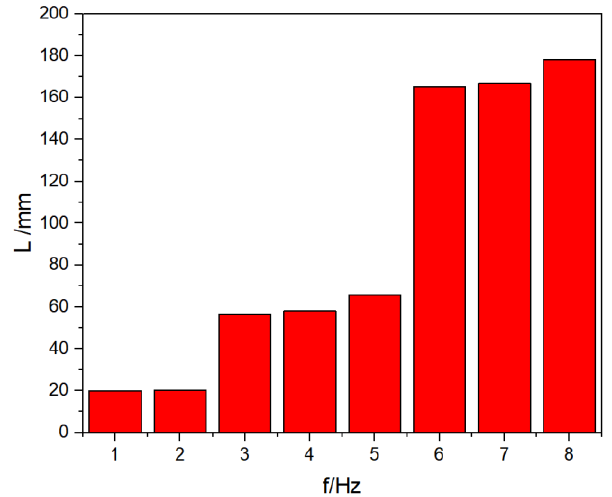
Figure 21. Frequency of L which value is 200 mm. Else if L value is 250 mm, which is as Figure 22.